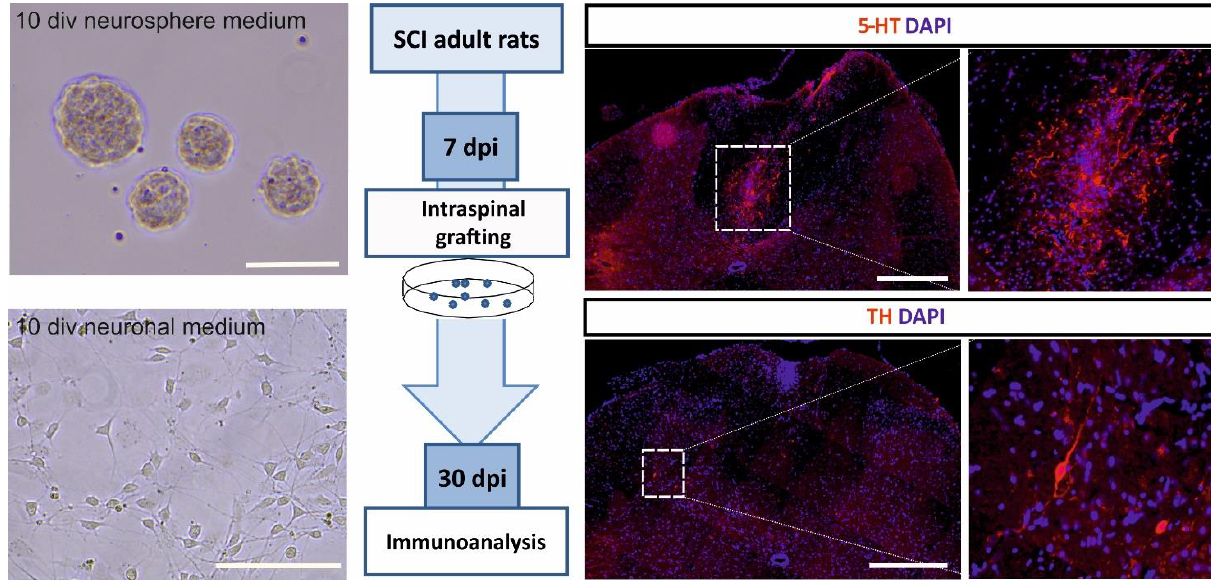
Figure 2. Schematic presentation of the results of preliminary experiments showing serotonergic precursors surviving and terminally differentiating after transplantation into the spinal cord injury-mediated environment. The left panel shows precursor morphology in different cell culture conditions: Neurosphere medium supports cell proliferation and neurosphere formation, neuronal medium induces their neuronal differentiation. Scale bars 100 µ m. The middle panel describes the experimental design: Expanded serotonergic precursors derived from rat embryonic brain stem (on embryonic day 11) were transplanted into the rat injured spinal cord 7 days post-injury and their morphology was examined after the next 30 days. The protocol for cell expansion was adopted from [196]. The right panel shows representative images of differentiated cells within host spinal cords. Transplant-derived serotonergic neurons were found in each examined in- jured spinal cord (three rats). Note the presence of serotonin (5-HT)-positive neurons (upper images) and thyrosine kinase (TH)-positive neurons (lower images). Control animals were injected with cell culture medium, no stained cells were de- tected (data not shown). Scale bars are 500 μ m. Functional experiments that examined the recovery of locomotor functions via restored innervation of the spinal cord are in progress.